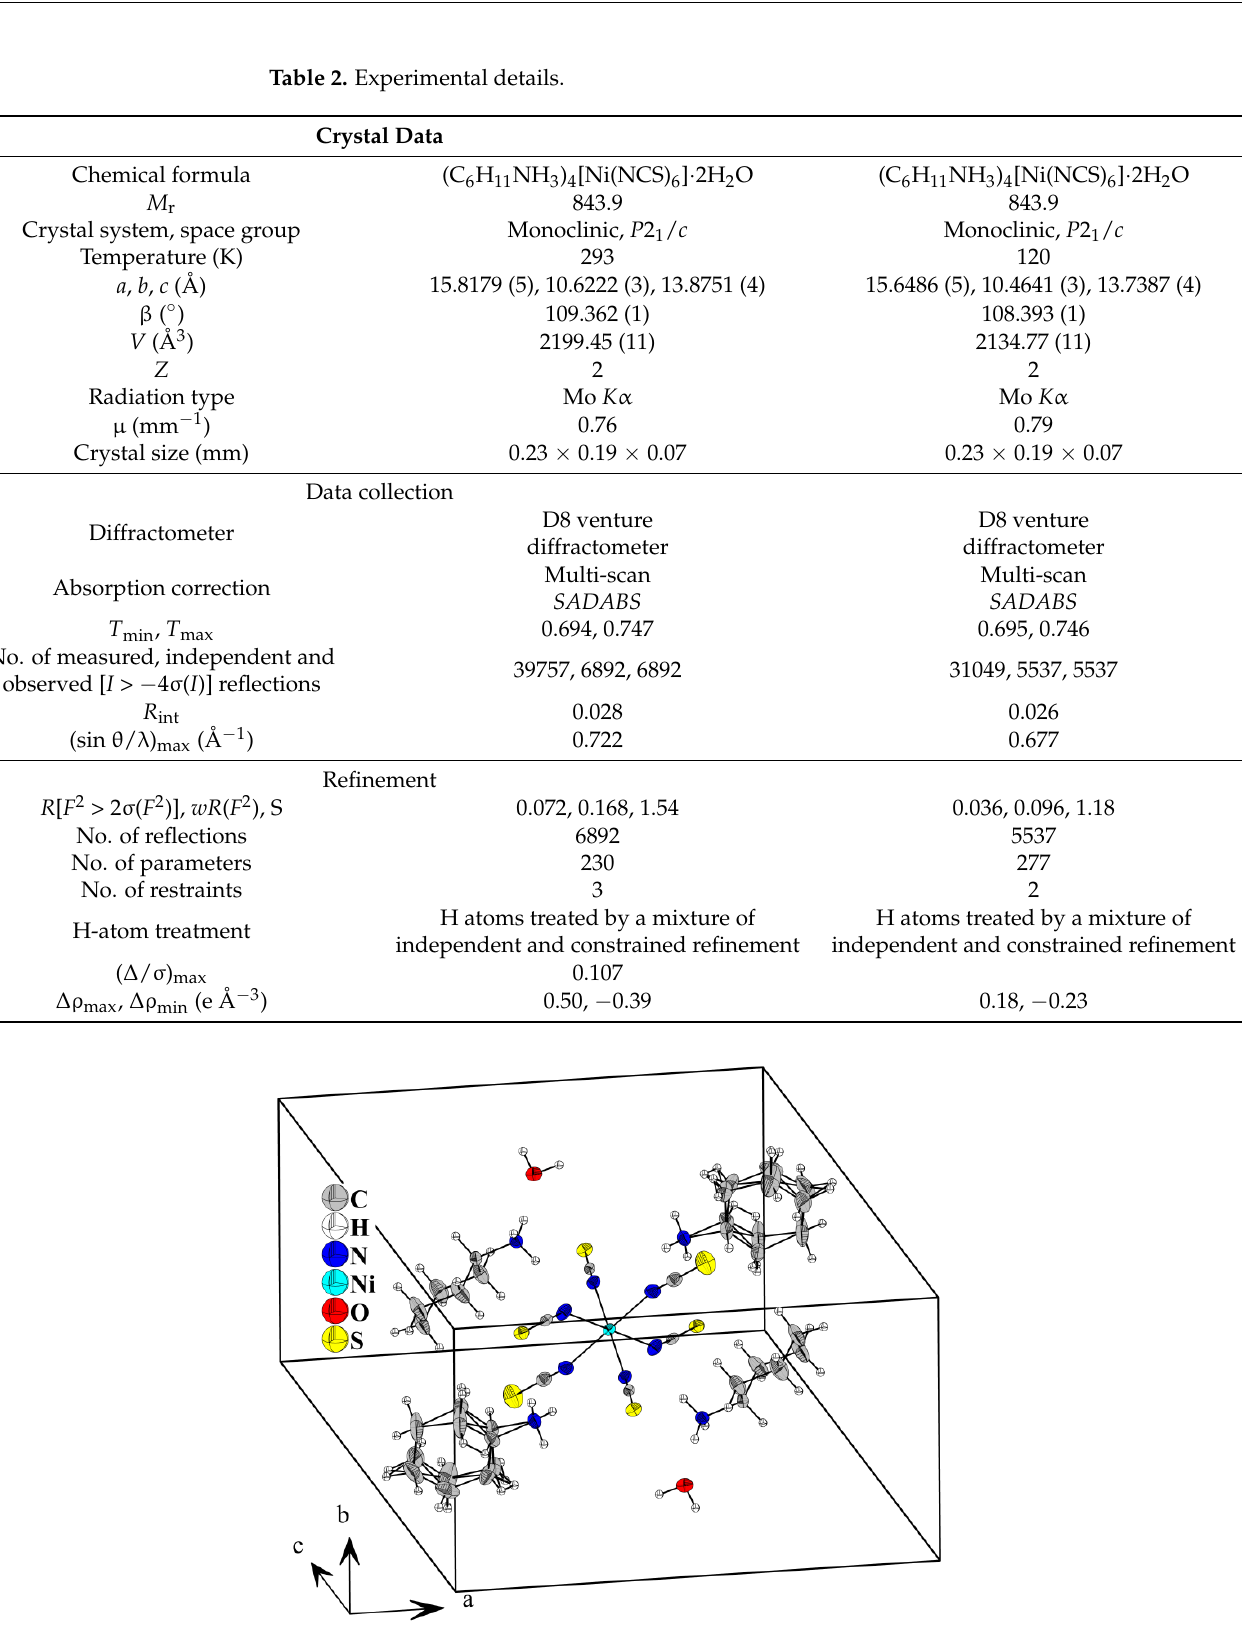
Figure 3. Perspective view of the unit cell of (C 6 H 11 NH 3 ) 4 [Ni(NCS) 6 ] · 2H 2 O at 120 K. Table 3. Selected angles and bond length of (C 6 H 11 NH 3 ) 4 [Ni(NCS) 6 ]·2H 2 O.